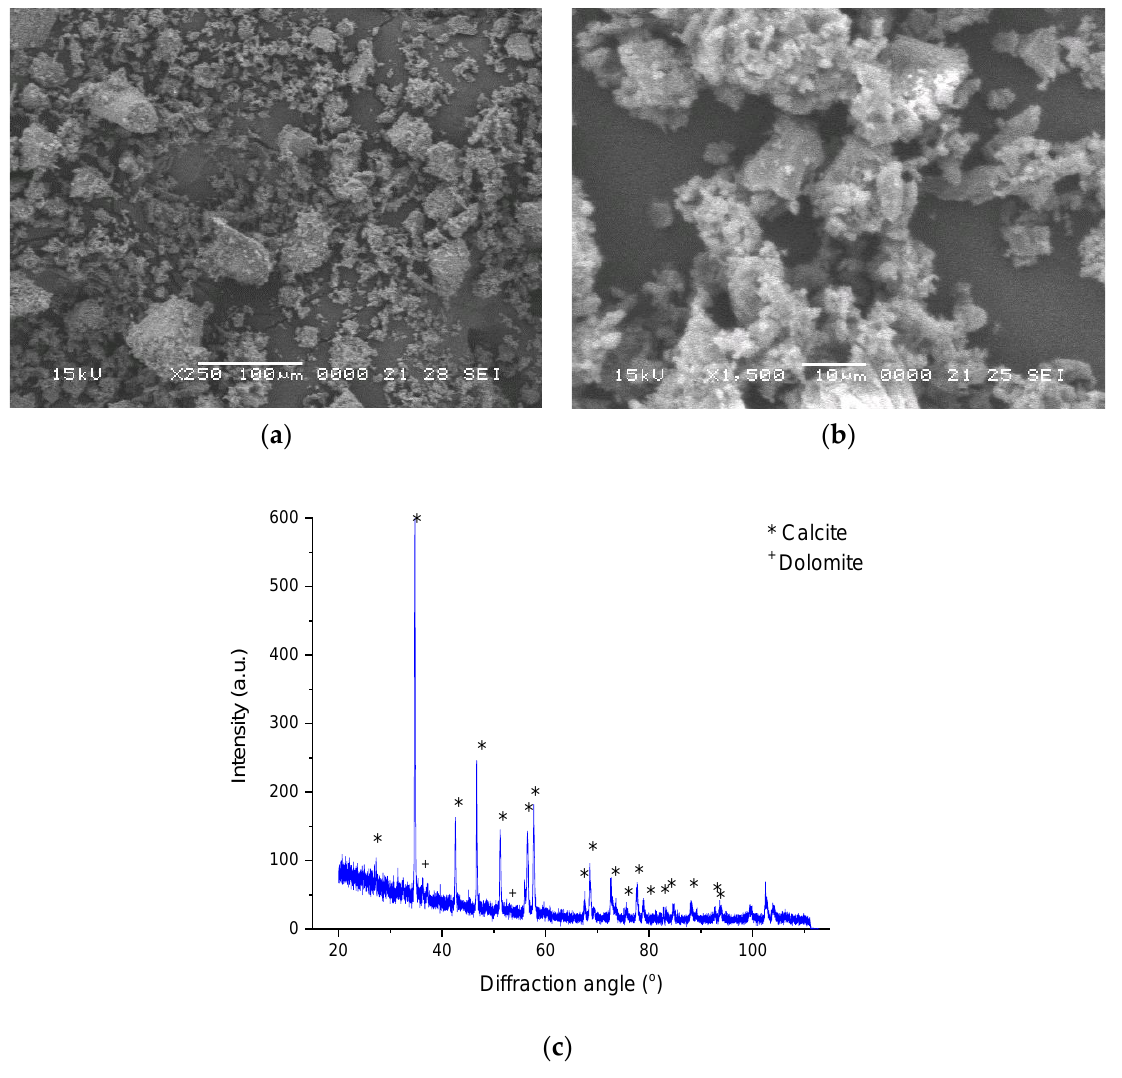
Figure 1. SEM images of limestone at low ( a ) and higher ( b ) magnification; X-ray diffraction pattern of the used powder ( c ).